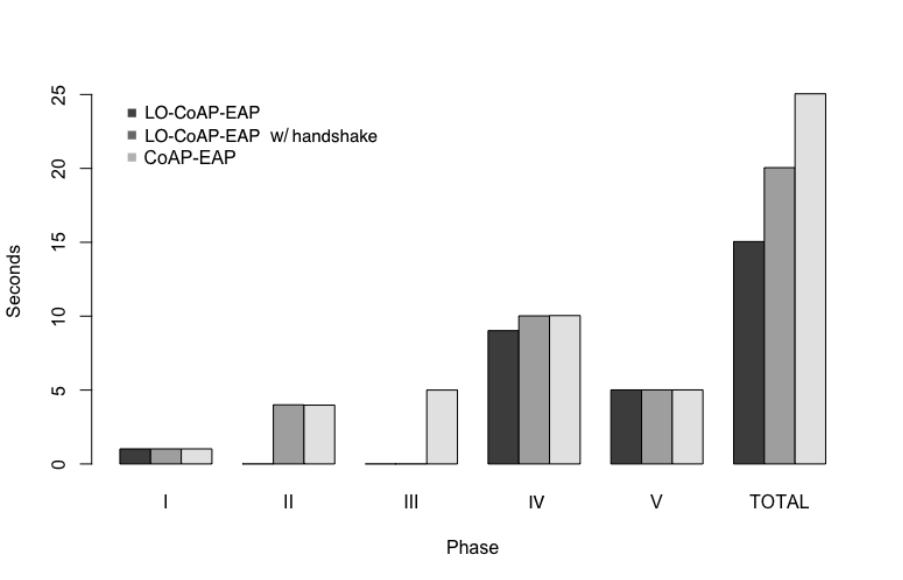
Figure 11. Network authentication